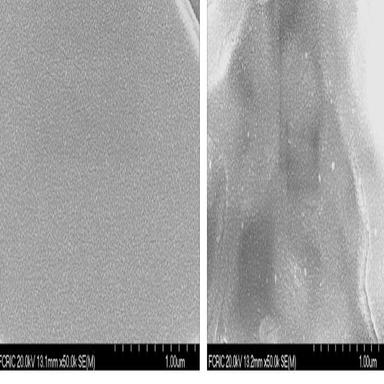
SEM images of the nanocomposites (a) Au0 (NPs)/TiO2 and Au0 (NPs)/TiO2(T) thin films.